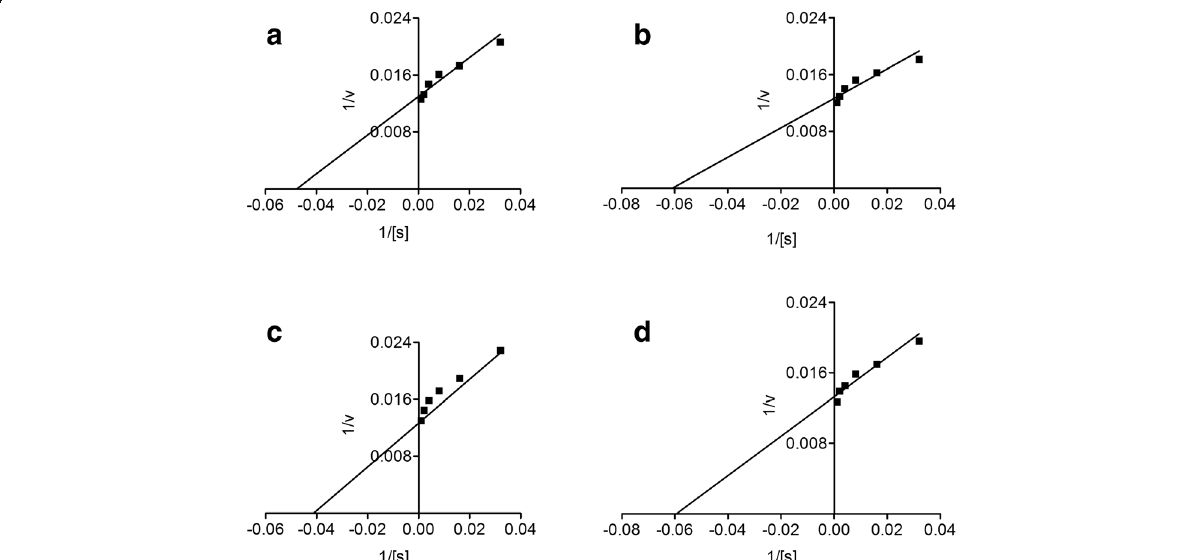
Fig. 6 Lineweaver-Burk plots representing the reciprocal of initial enzyme velocity versus the reciprocal of substrate concentration in the presence of different concentrations of ON-Cr and the positive control galantamine for acetylcholinesterase ( a and b ) and butyrylcholinesterase ( c and d ), respectively